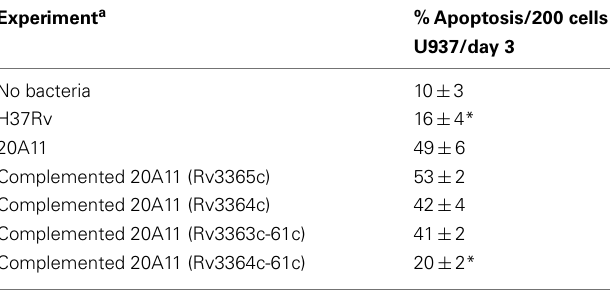
Table 1 | Comparisons of the levels of apoptosis in macrophages infected with different clones of M. tuberculosis